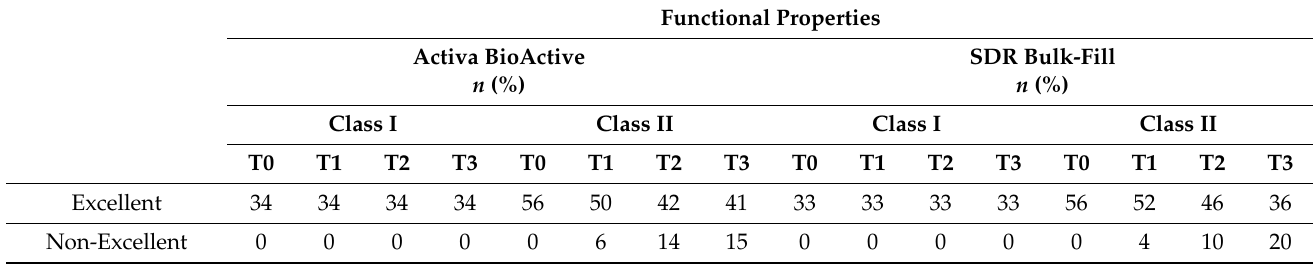
Table 8. Overall evaluation of functional properties based on material used and restoration class. Functional